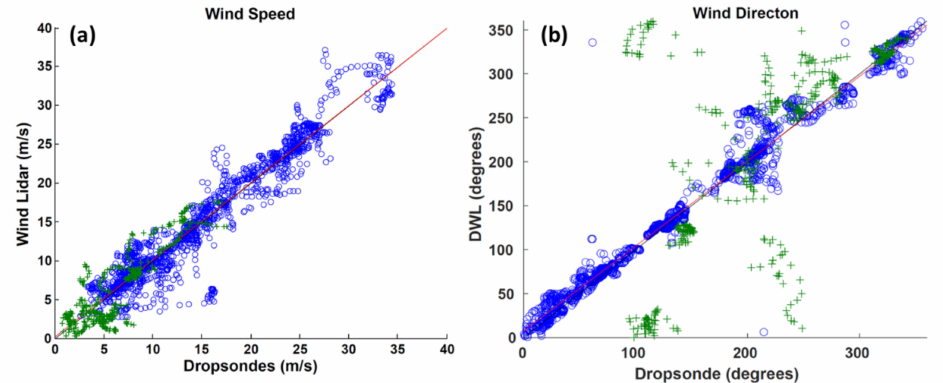
Figure 4. ( a ) Comparison of collocated ADWL and dropsonde wind speed observations (m s − 1 ) outside of the TC center (blue o symbols) and within the TC center (green + symbols). Also shown are the line of best fit (red) and the line of perfect correlation (black); ( b ) Same as ( a ) but with collocated ADWL and dropsonde wind directions. ADWL winds are calculated from 5 or more LOS